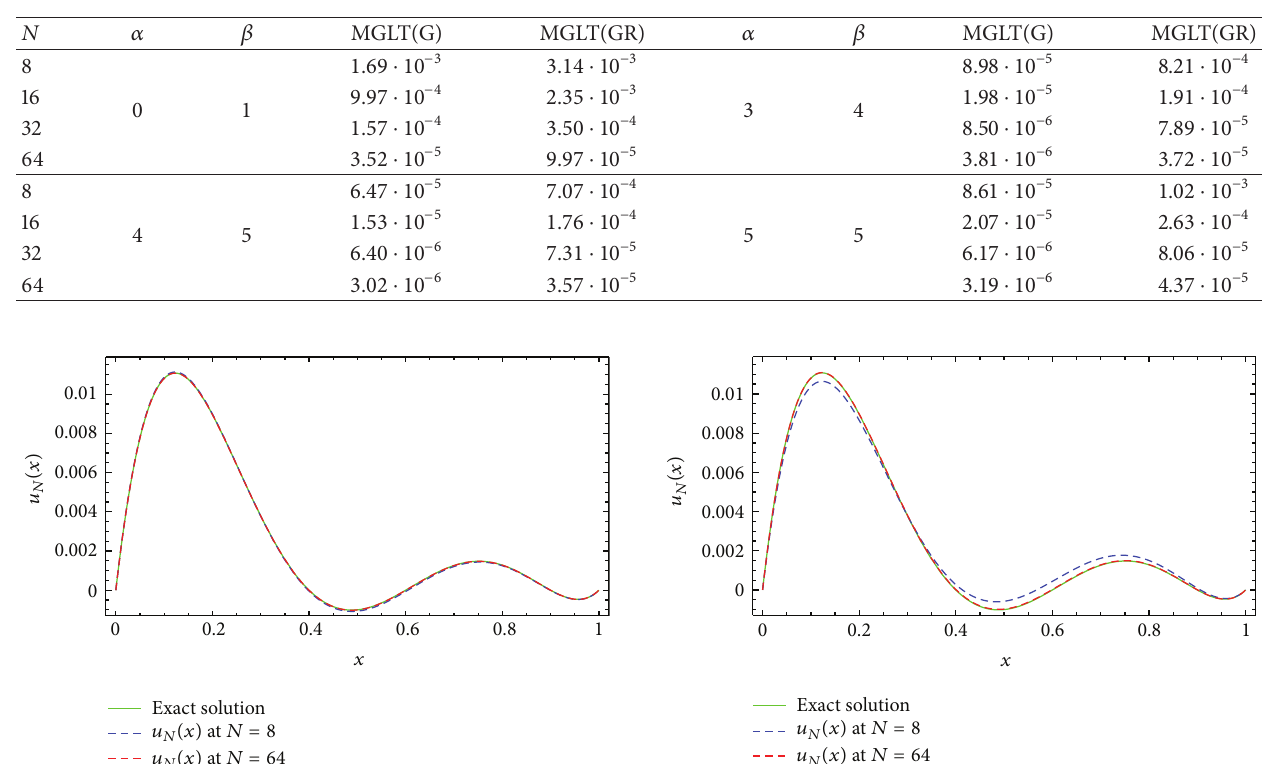
Table 4: Maximum absolute error for ] = 3/2 , with various choices of 𝑁 , for Example 5 in which 𝑥 ∈ (0,1) .